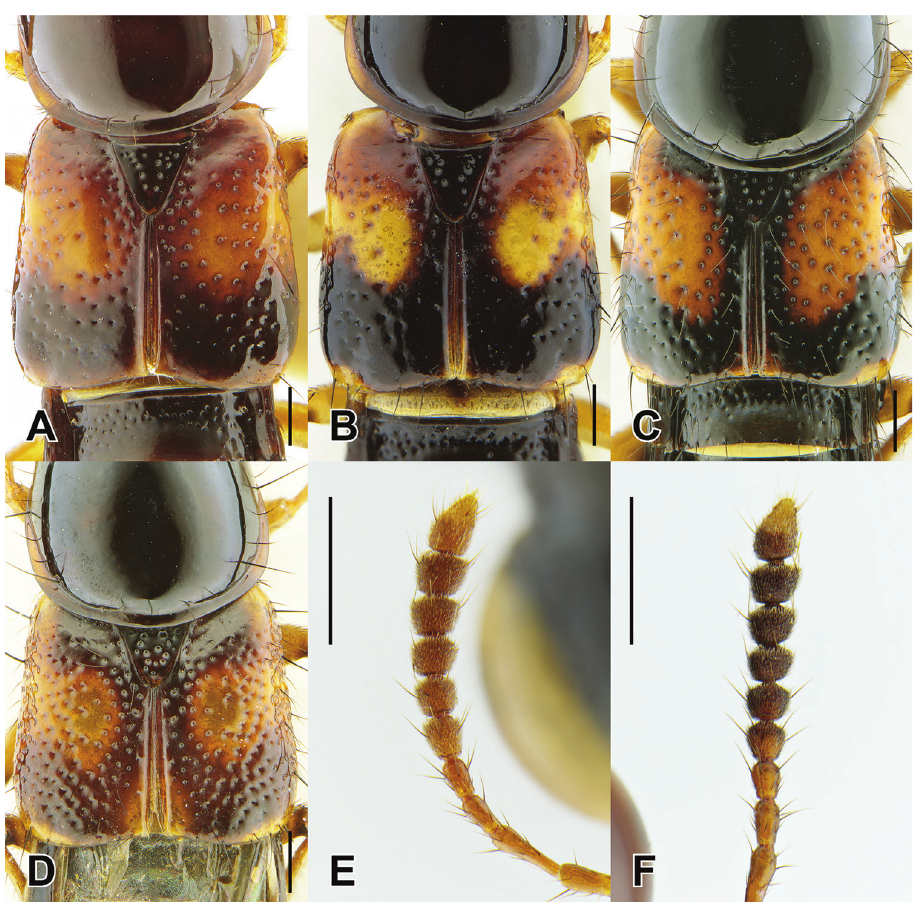
Figure 6. Elytra: Bolitogyrus taiwanensis (Hayashi) ( A ), B. fukiensis (Scheerpeltz) ( B ), B. flavus Yuan et al. ( C ) and B. rougemonti Brunke ( D ). Antenna: B. taiwanensis ( E ) and B. flavus ( F ). Scale bars: 0.5